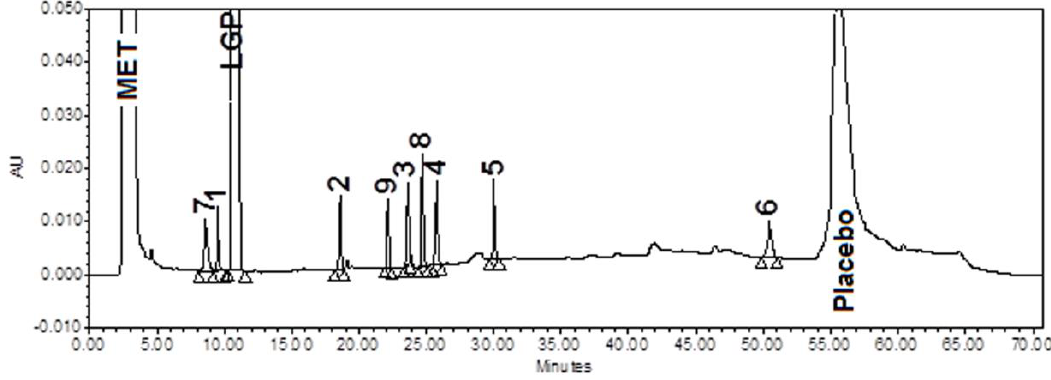
Figure 4. Chromatogram of impurity mix solution including identified impurities i.e., Impurity-VII ( 7 ), Impurity-VIII ( 8 ), and Impurity-IX ( 9 ).